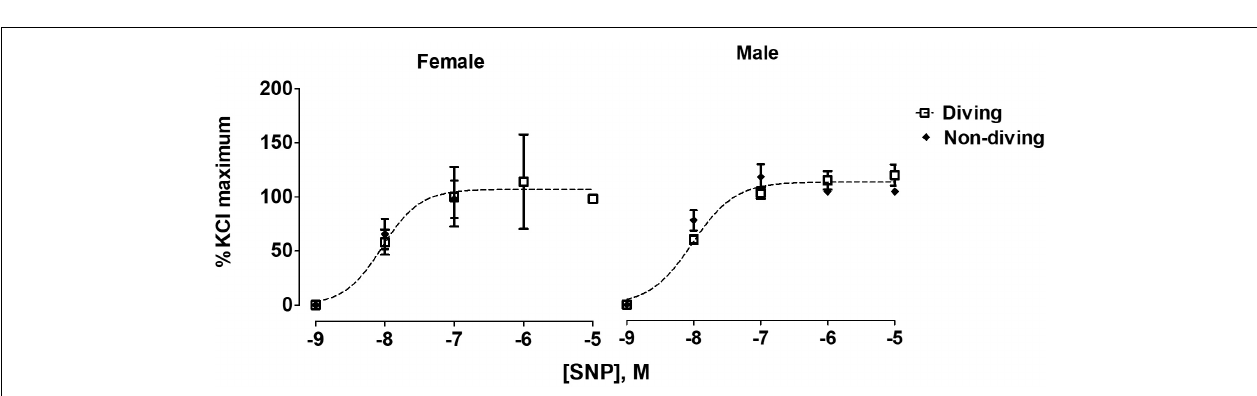
FIGURE 7 | Area under curve for relaxation responses of mesenteric arteries in ApoE KO rats to acetylcholine (ACh) in the presence of inhibitors for different endothelium-dependent relaxing pathways; ANOVA and t -test.